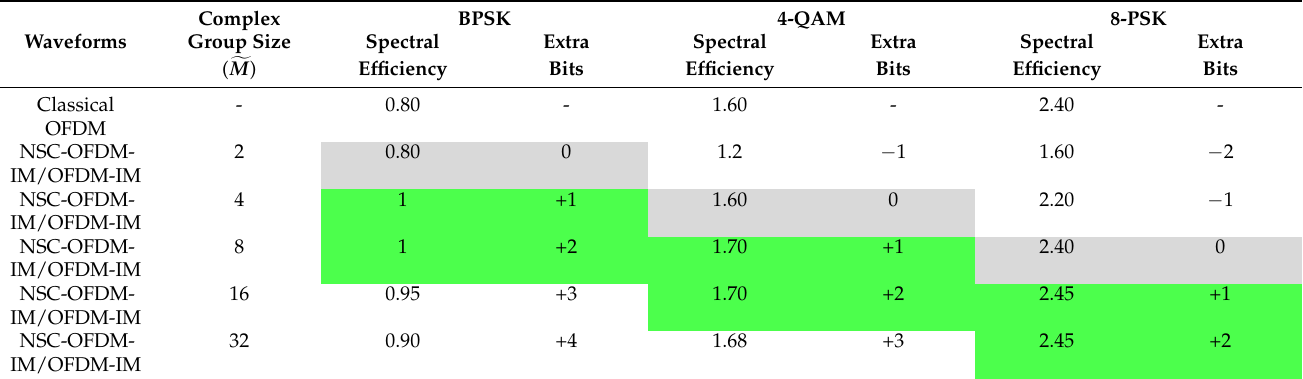
Table 3. Spectral efficiencies of OFDM, OFDM-IM, and NSC-OFDM-IM ( N FFT = 128, N cp = 32, n = (cid:101) M , and k = (cid:101) M − 1).